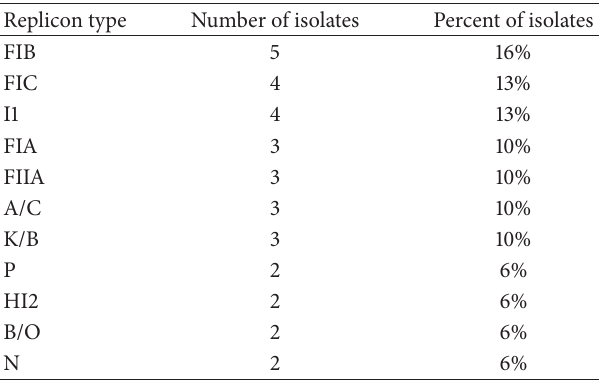
Table 3: Frequency of plasmid replicon types detected from E. coli isolates ( 𝑛 = 31 ) from surface waters in northern